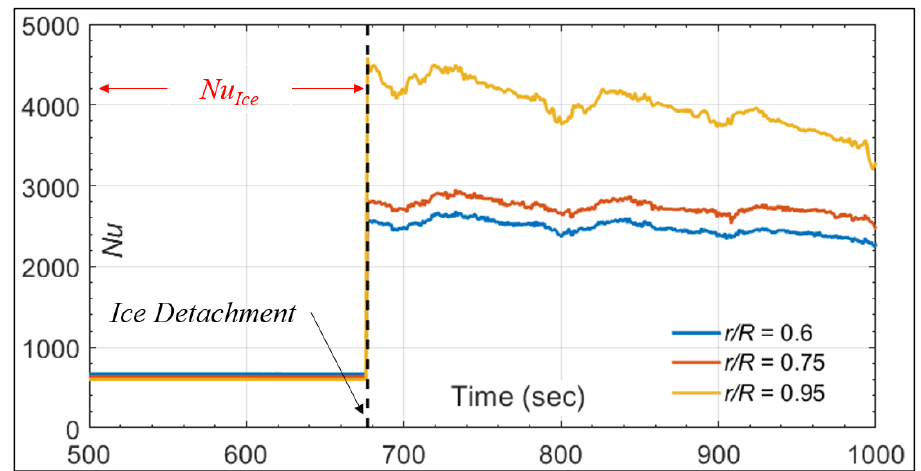
Figure 8. Instantaneous Variation in the Nu ( t ) for the De-Icing Test at T ∝ = 265.65 K for Ω = 1000 RPM and V ∝ = 20 m/s (Test #9).